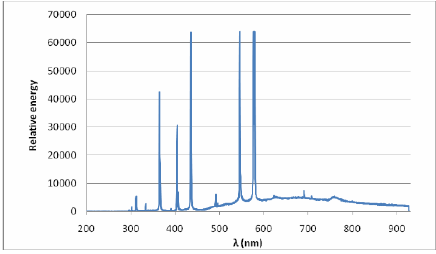
Figure 1. Emission spectrum of Osram UltraVitalux UV-Vis lamp.